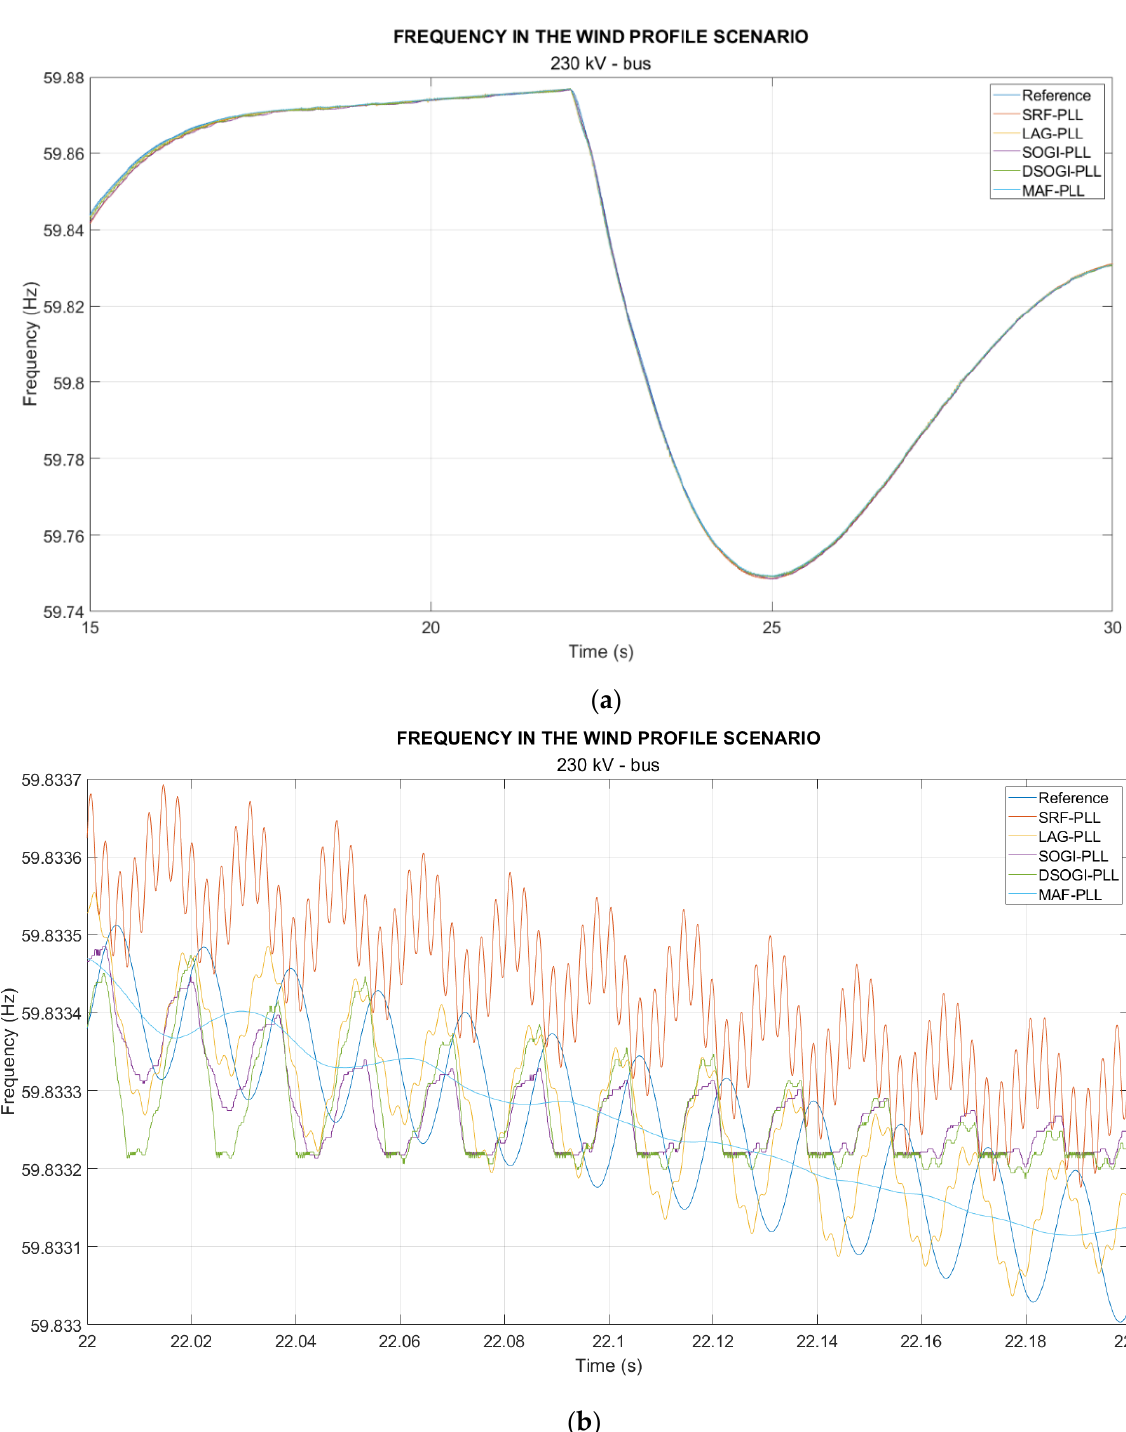
Figure 14. Frequency measurement with the PLLs located at the 230 kV bus: ( a ) PLLs measuring from seconds 15 to 35, and ( b ) detail of the measurements from seconds 22 to 22.2.